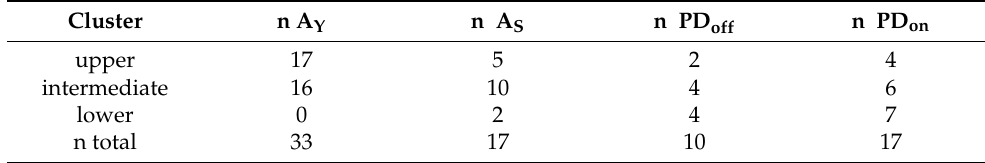
Table 4. Confusion matrix of the repartition of subjects into clusters.